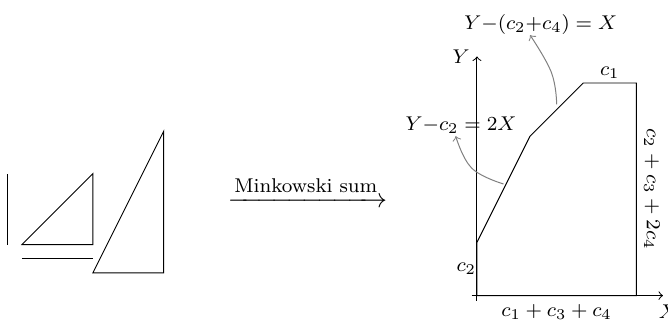
Figure 5 . The generalized associahedron (or cyclohedron) for A ( B 2 ) as a Minkowski sum. given